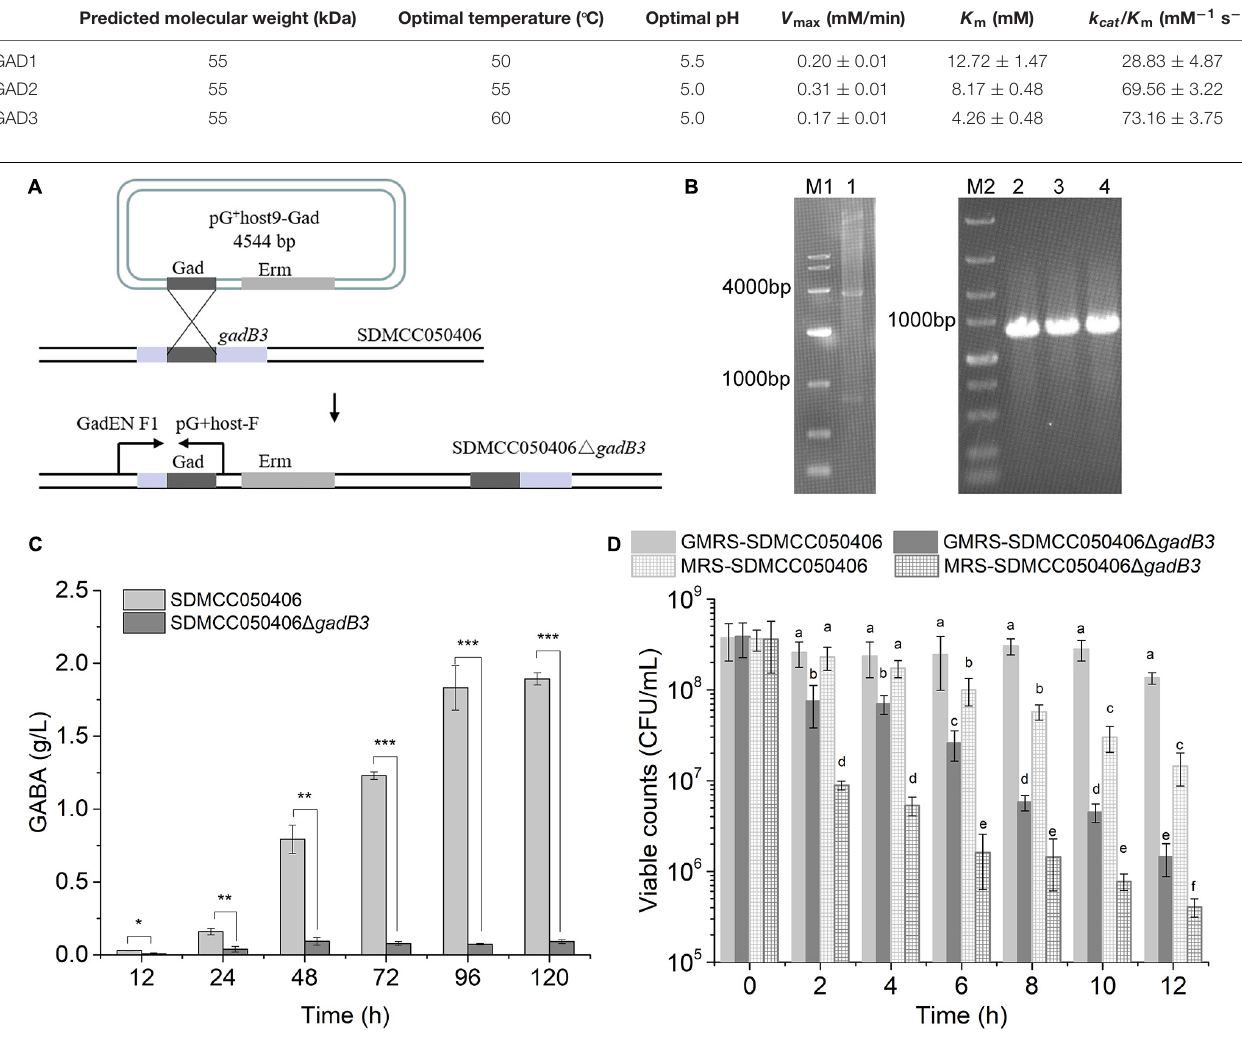
TABLE 3 | Comparison of properties of three GADs purified from E. avium SDMCC050406. Predicted molecular weight (kDa)